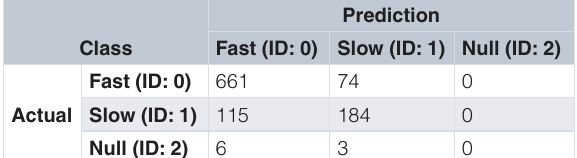
Table 12. Confusion matrix of clearance rate predictions versus